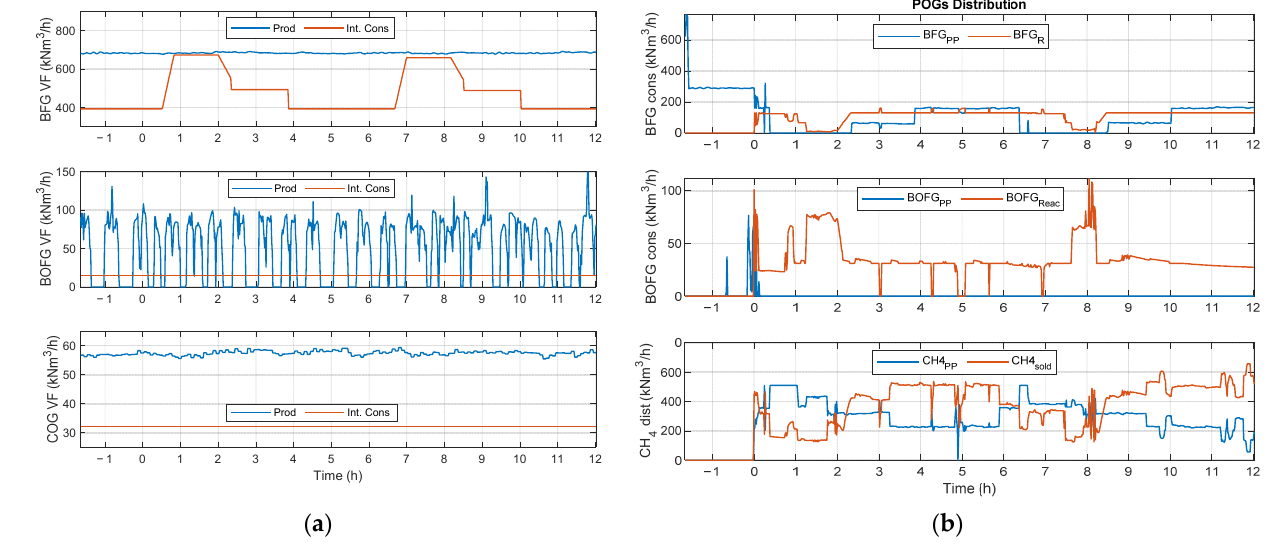
Figure 8. SC1. ( a ) POG production and consumption by internal users; ( b ) POG distribution to PP and methane reactors and methane consumption in PP and sent to market.